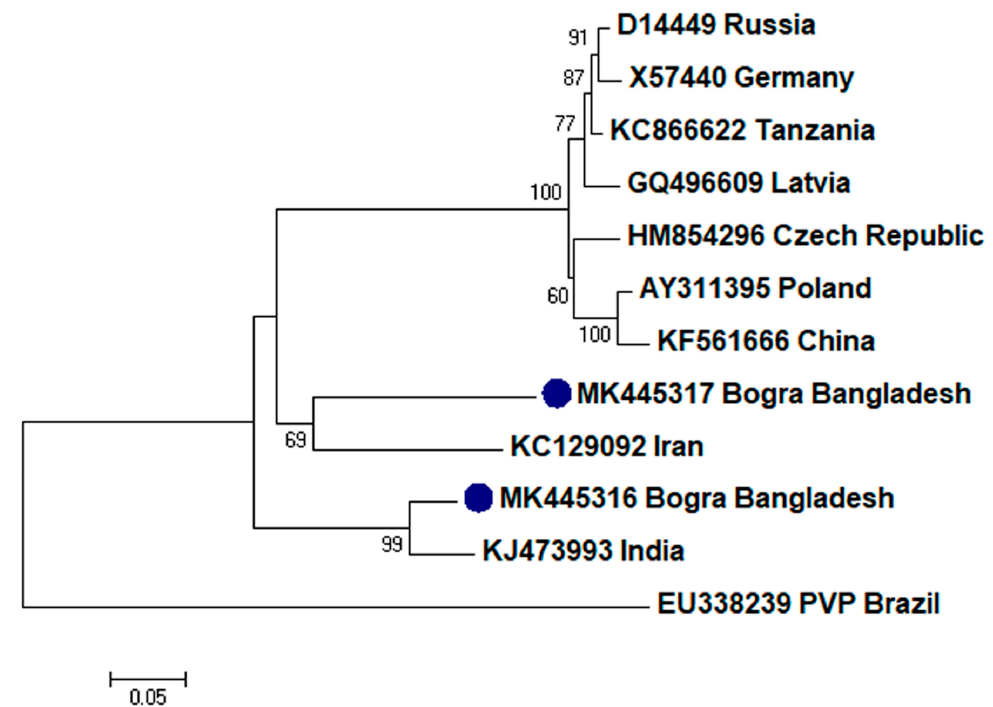
Figure 7. Phylogenetic analysis of Potato virus M detected from Bangladesh based on the coat protein gene sequences (nt) of different selected isolates from the NCBI database. The phylogenetic tree was generated by MEGA7 using neighbor-joining method with 1000 bootstrap replicates, and only values >50% are shown at the nodes. An isolate of Potato virus P (PVP) from Brazil was used as an outgroup.